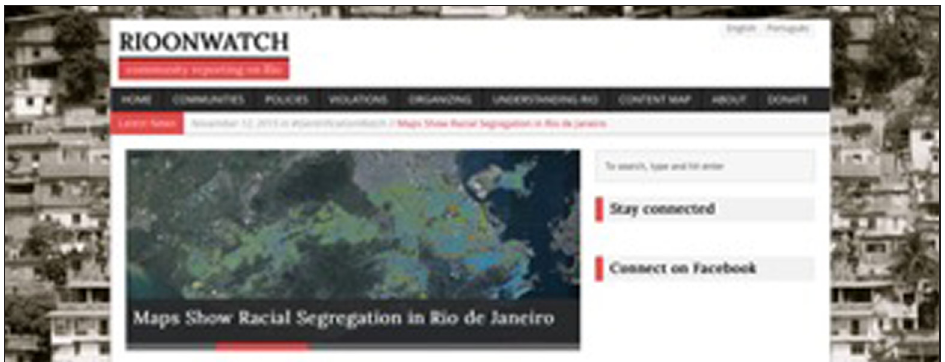
Figure 1: Map of Racial Segregation in Rio de Janeiro, as it appeared on the Rio on Watch website